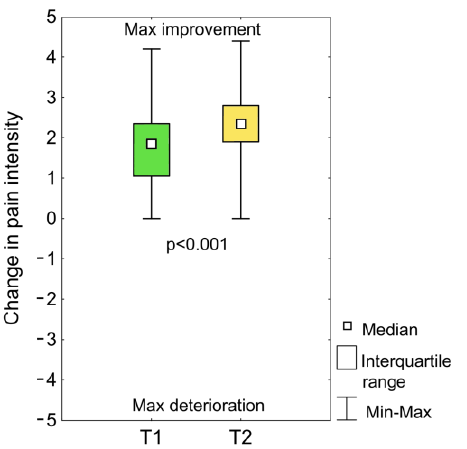
Figure 3. Change in pain intensity after the initial taping (T1) and after one month of use after the removal of the tape (T2); p = statistical significance, 0 = no change, 1 to 5 = improvement or decrease in pain, −1 to −5 = deterioration or increase in pain.